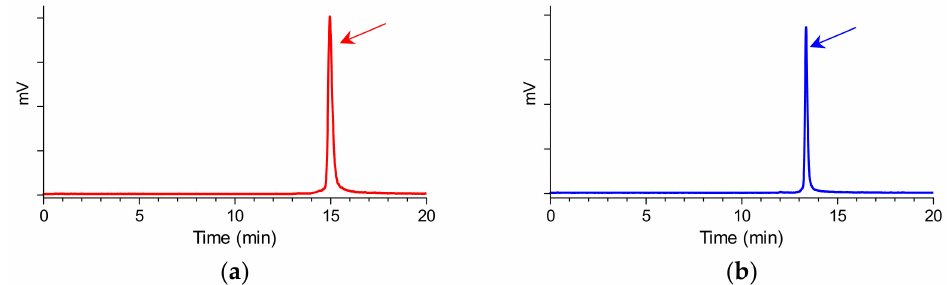
Figure 2. Representative radiochromatograms of the radiolabeling reaction mixture of ( a ) 99m Tc-N 4 -GRP(14–27) (red) and ( b ) 99m Tc-N 4 -GRP(18–27) (blue), confirming the quantitative formation of high purity radioligands at t R = 14.9 min and t R = 13.3 min, respectively (HPLC system